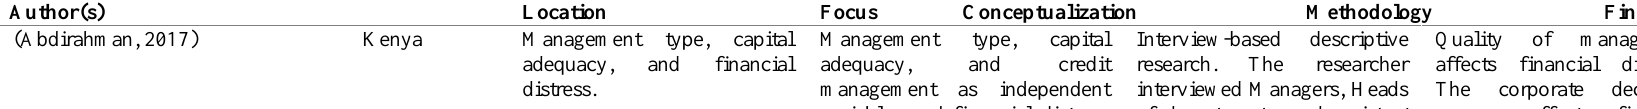
Table 2: Summary of Empirical